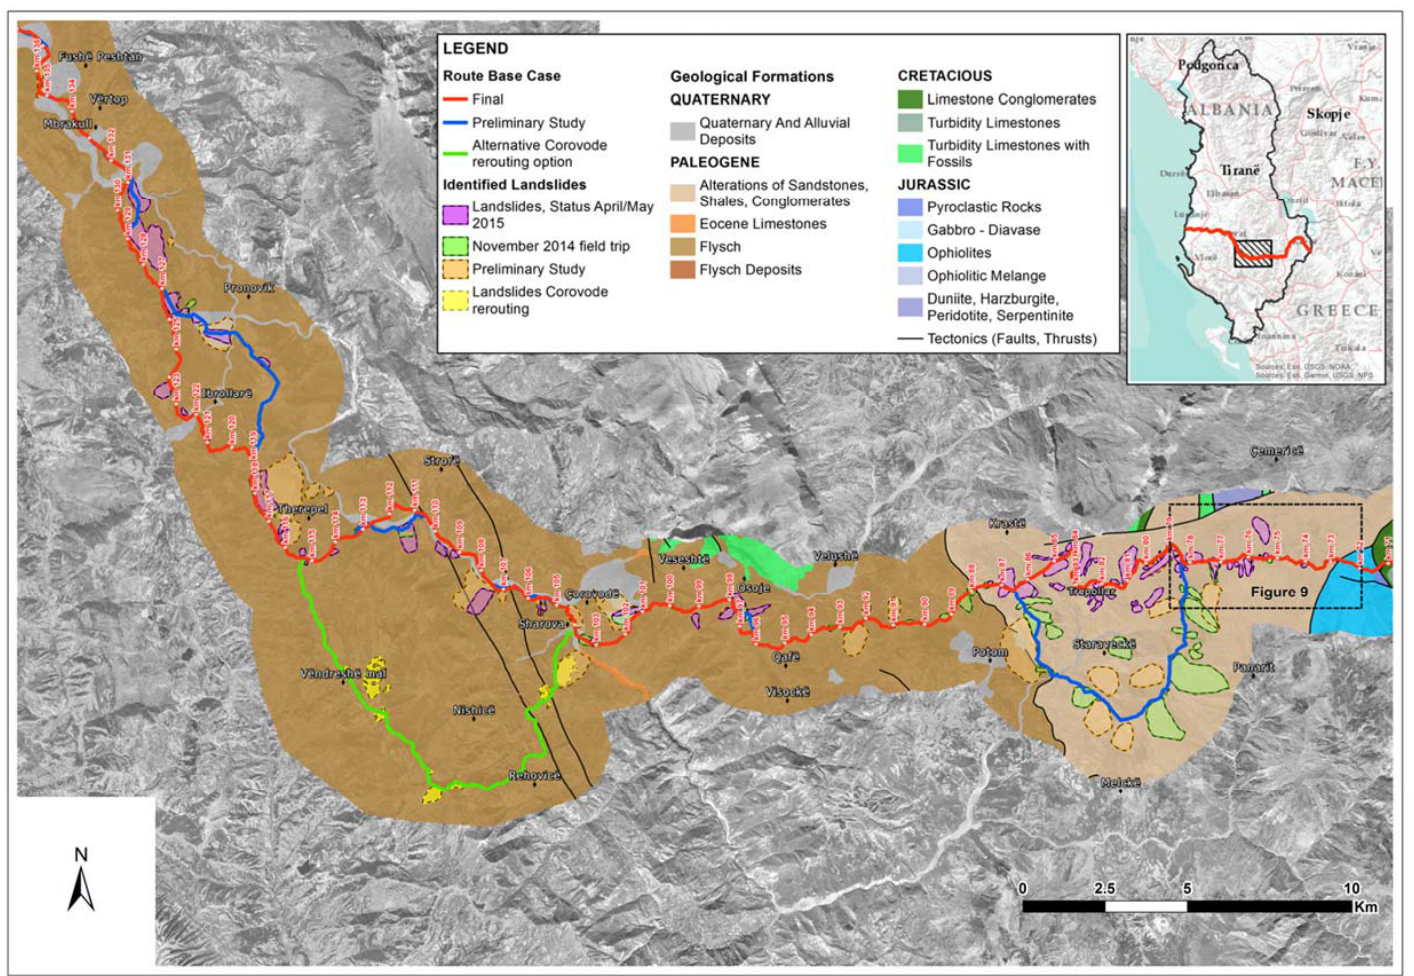
Figure 5. Geological conditions along the Trans Adriatic Pipeline (section 71–136 Km). The geological environment of the area is dominated by flysch formations. Limestones and ophiolites (peridotites) were also identified at the eastern edge.